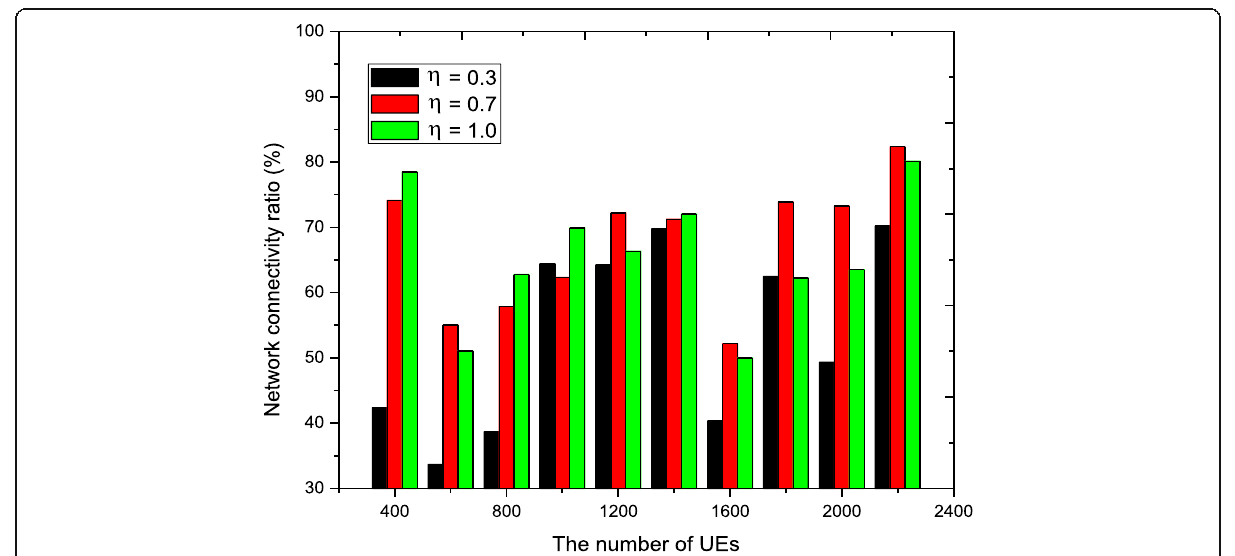
Fig. 12 Network connectivity ratio for the DTO-MROD scheme under the different typical values for η